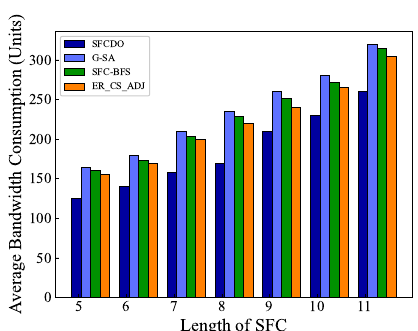
Figure 8. Average bandwidth consumption of SFCs in large topology.